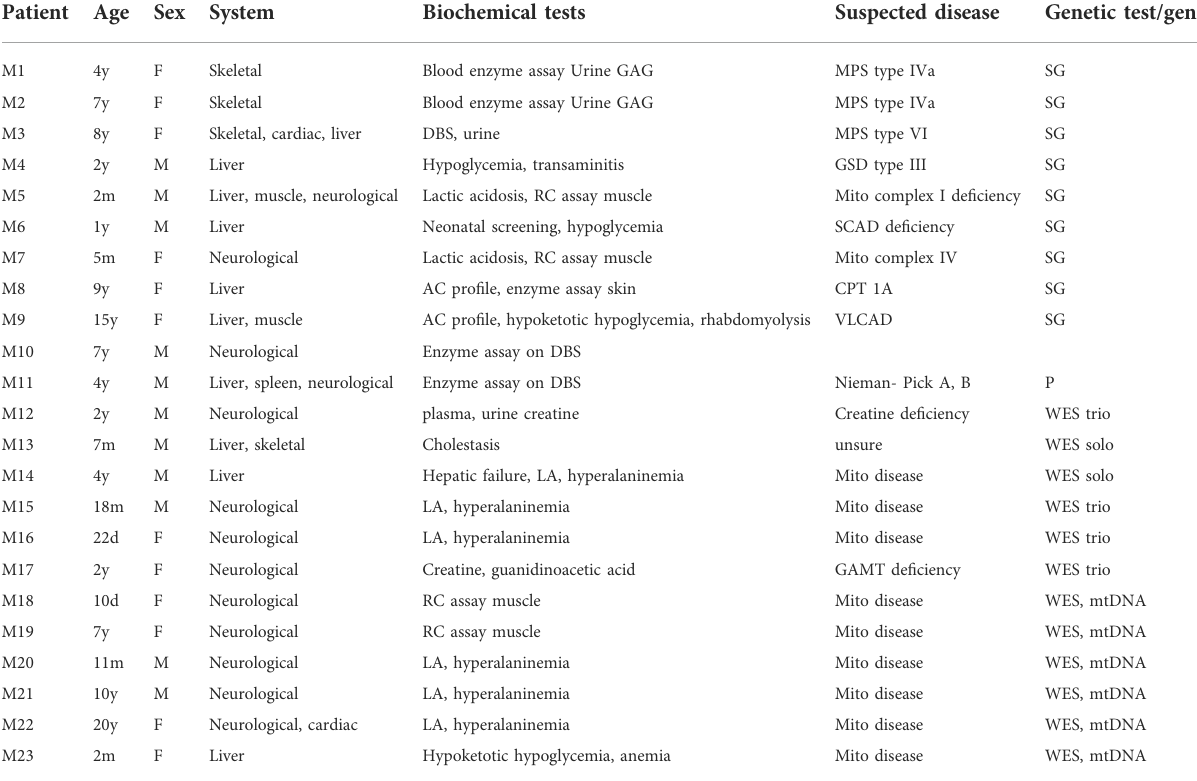
TABLE 3 Suspected IEM patients with negative genetic testing: Clinical and biochemical correlation.